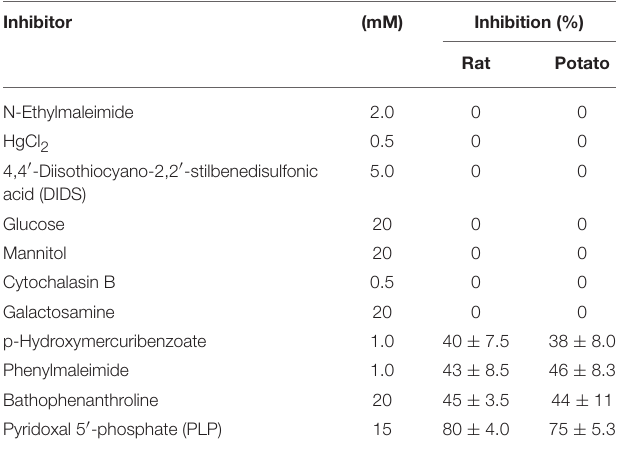
TABLE 2 | Effect of inhibitors on the reconstituted ascorbic acid unidirectional uptake. Inhibitor (mM) Inhibition (%)